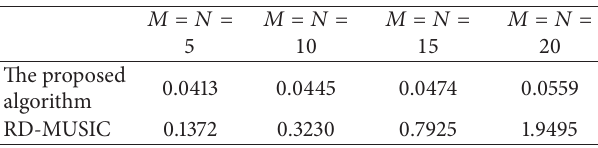
Figure 5: The performance for DOD and DOA estimation with different 𝑀 . (a) DOD and (b) DOA. Table 1: Averaged time consumption of the proposed algorithm and RD-MUSIC with respect to 𝑀 and 𝑁 . Time unit: